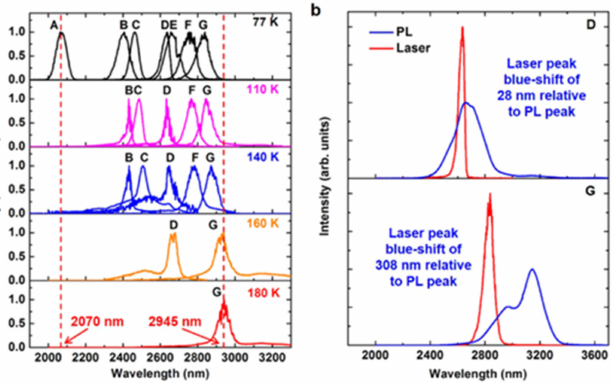
Figure 25. ( a ) GeSn laser spectra for samples A–G; ( b ) comparison of the PL and laser spectra of samples D and G. Reproduced with permission from [73], American Chemical Society, 2017.